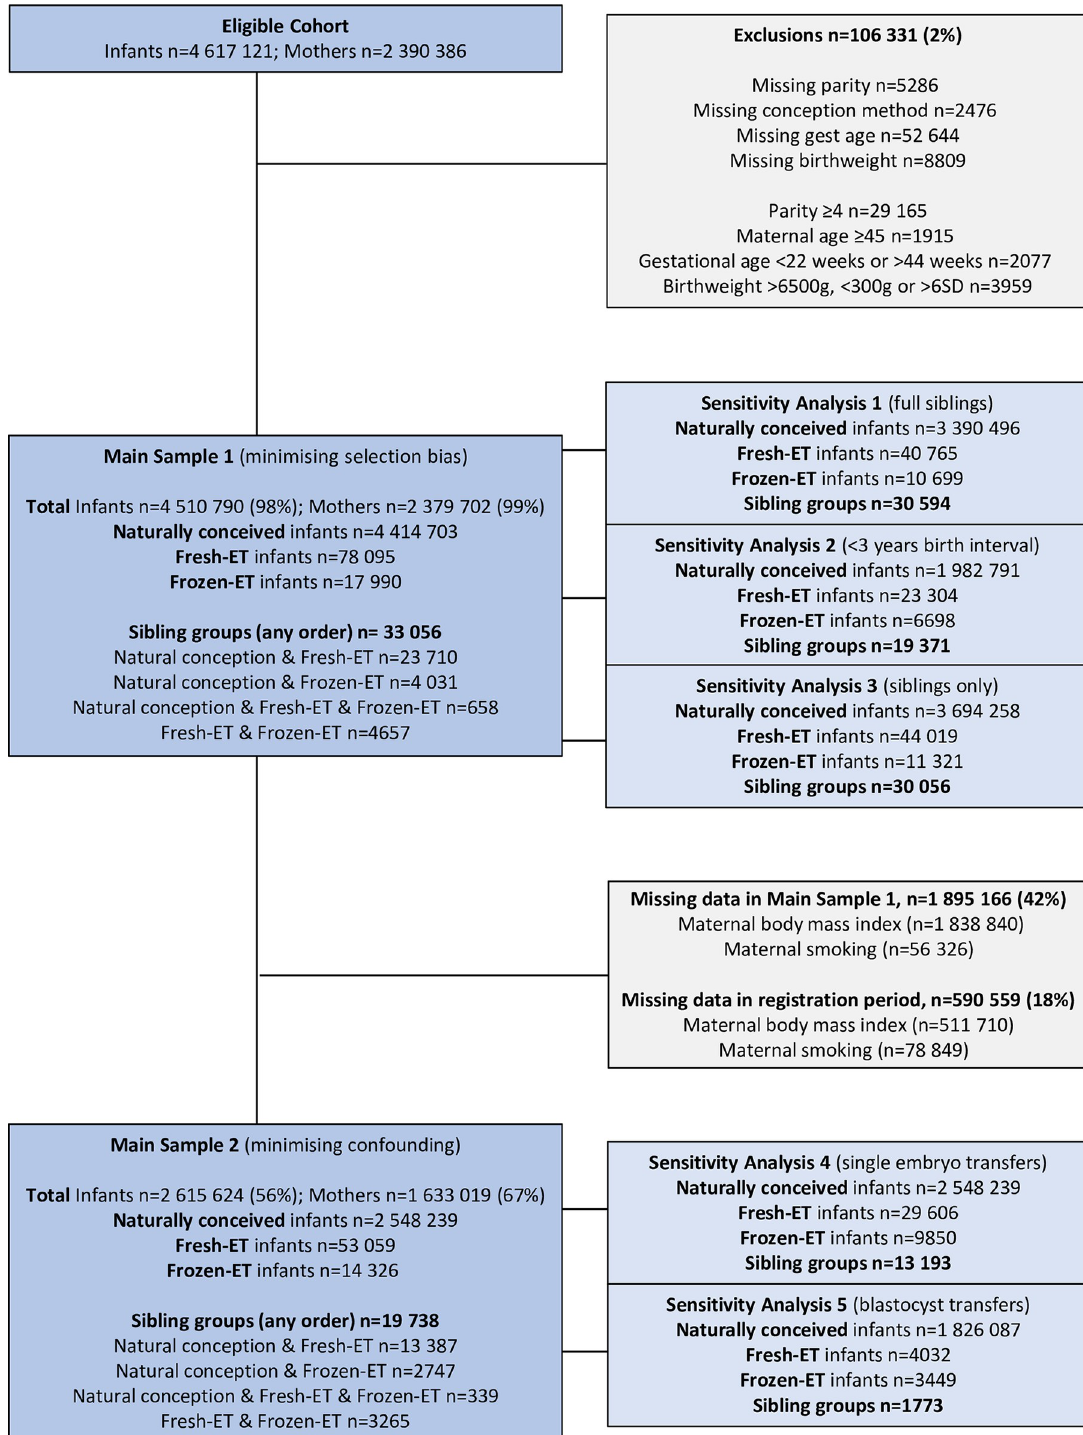
Fig 1. Flow chart AU : Inthemaintext ; thewordingregardingsensitivityanalysis 2 ð bornwithina 3 (cid:0) yearinterval ½ 2 �� andbornmorethan 3 yearsapart Þ indicatesasplitof � 3 and > 3 years : ButinFig 1 ; sensitivityanalysis 2 isdescribedasinvolving < 3 yearsbirthinterval ð i : e :; asplitof < 3 and � 3 Þ : Pleasefixthisinconsistency : of the study population. AU : InFig 1 ; intheexclusionsbox ; Parity � 3 asanexclusioncriterionisinconsistentwiththemaintext : Inthemaintextwomenwithparity ¼ 3 seemtobeincluded ð perTable 1 Þ andwomenwithparity � 4 areexcluded ð pertheMethods Þ : IfthisisanerrorinFig 1 ; pleasefix : Ifitisnotanerror ; pleaseclarifyorcorrecttheinconsistenciesinthemaintext : If not otherwise specified, sibling groups refer to maternal offspring siblings conceived through at least 2 of the 3 different conception methods. Fresh-ET, fresh embryo transfer; Frozen-ET, frozen embryo transfer; gest,